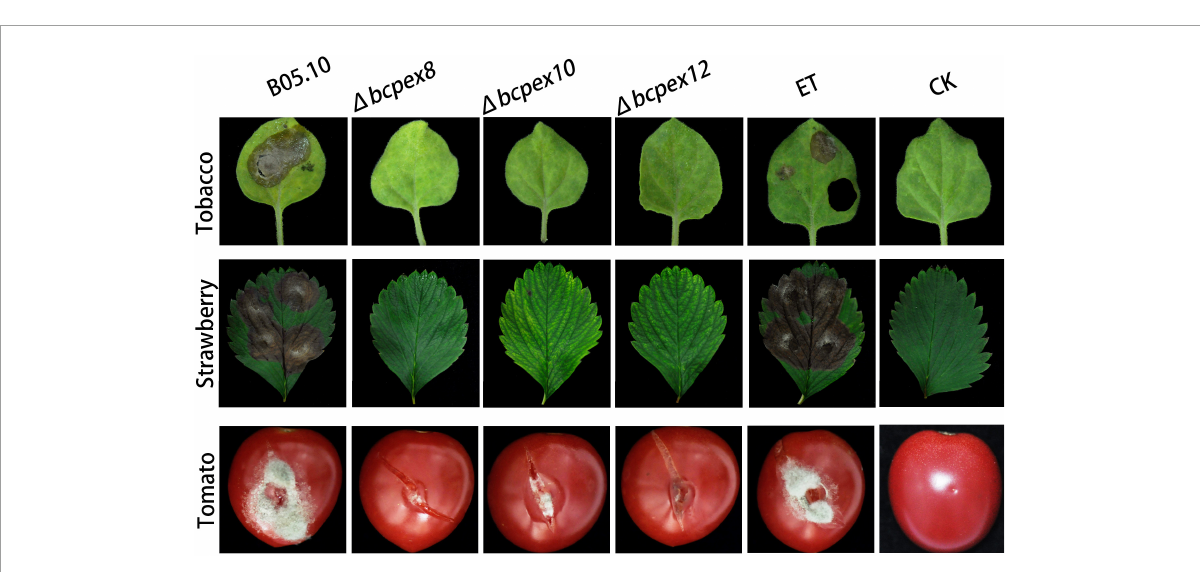
FIGURE8 Pathogenicity of the bcpex8/10/12 deletion mutants on tobacco leaves, strawberry leaves, and tomato